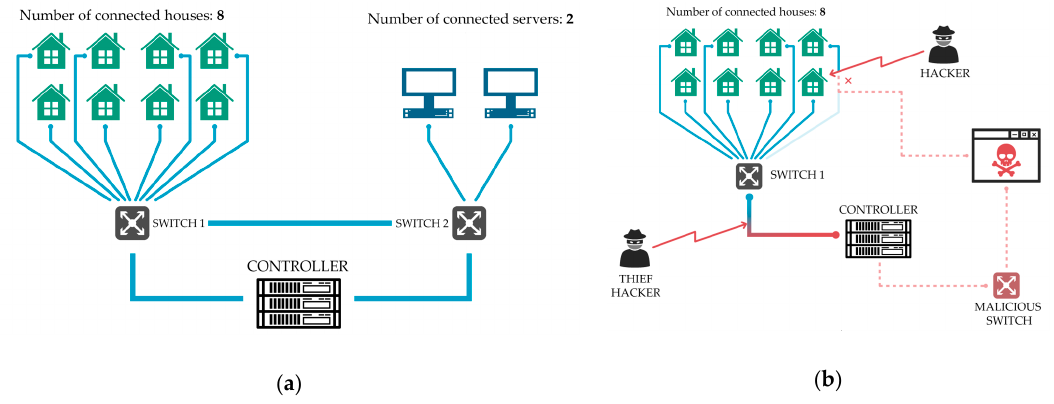
Figure 1. Use case: ( a ) Topological illustration of the application scenario with 8 smart meters and one controllers; ( b ) Representation of the practical scenario taking into account the presence of a